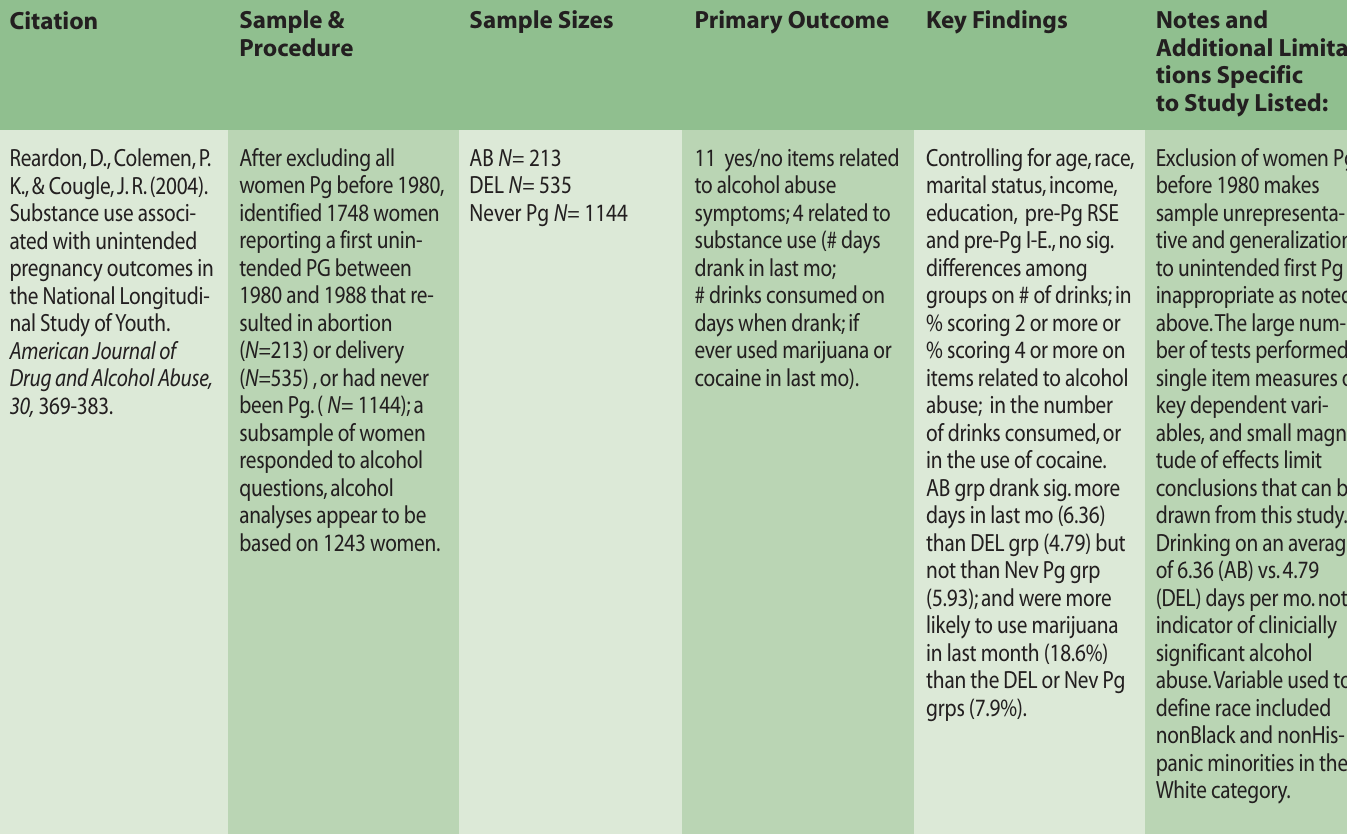
Table 1B: Secondary Analyses of Survey Data–Abortion vs.Comparison Groups U.S.STUDIES